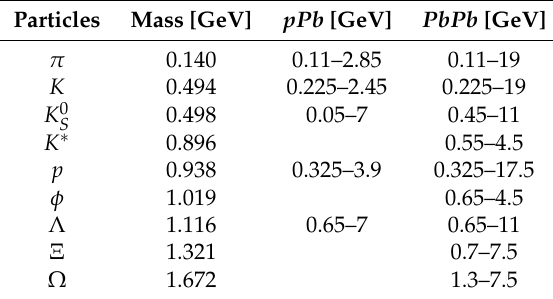
Table 4. Fitting p T range of different hadron spectra in heavy-ion collisions in this work